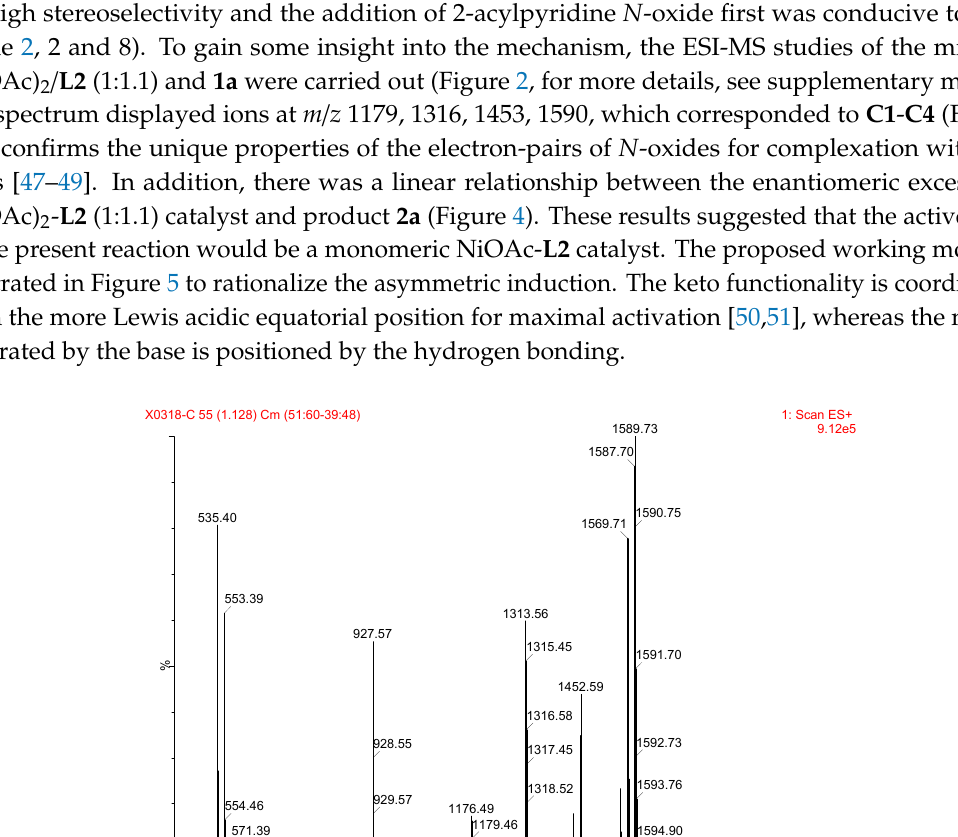
Figure 2. ESI-MS of Ni(OAc) 2 / L2 / 1a = 0.1/0.11/1.